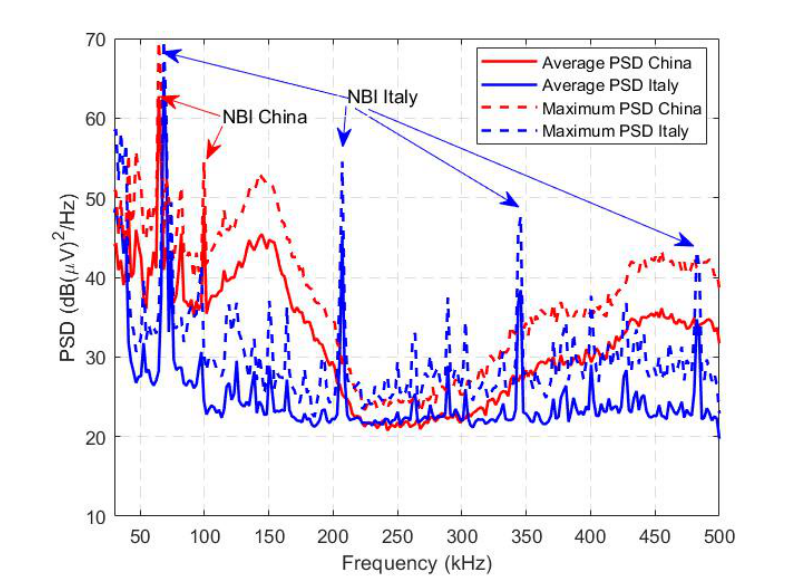
Figure 4. Noise PSD comparison between China and